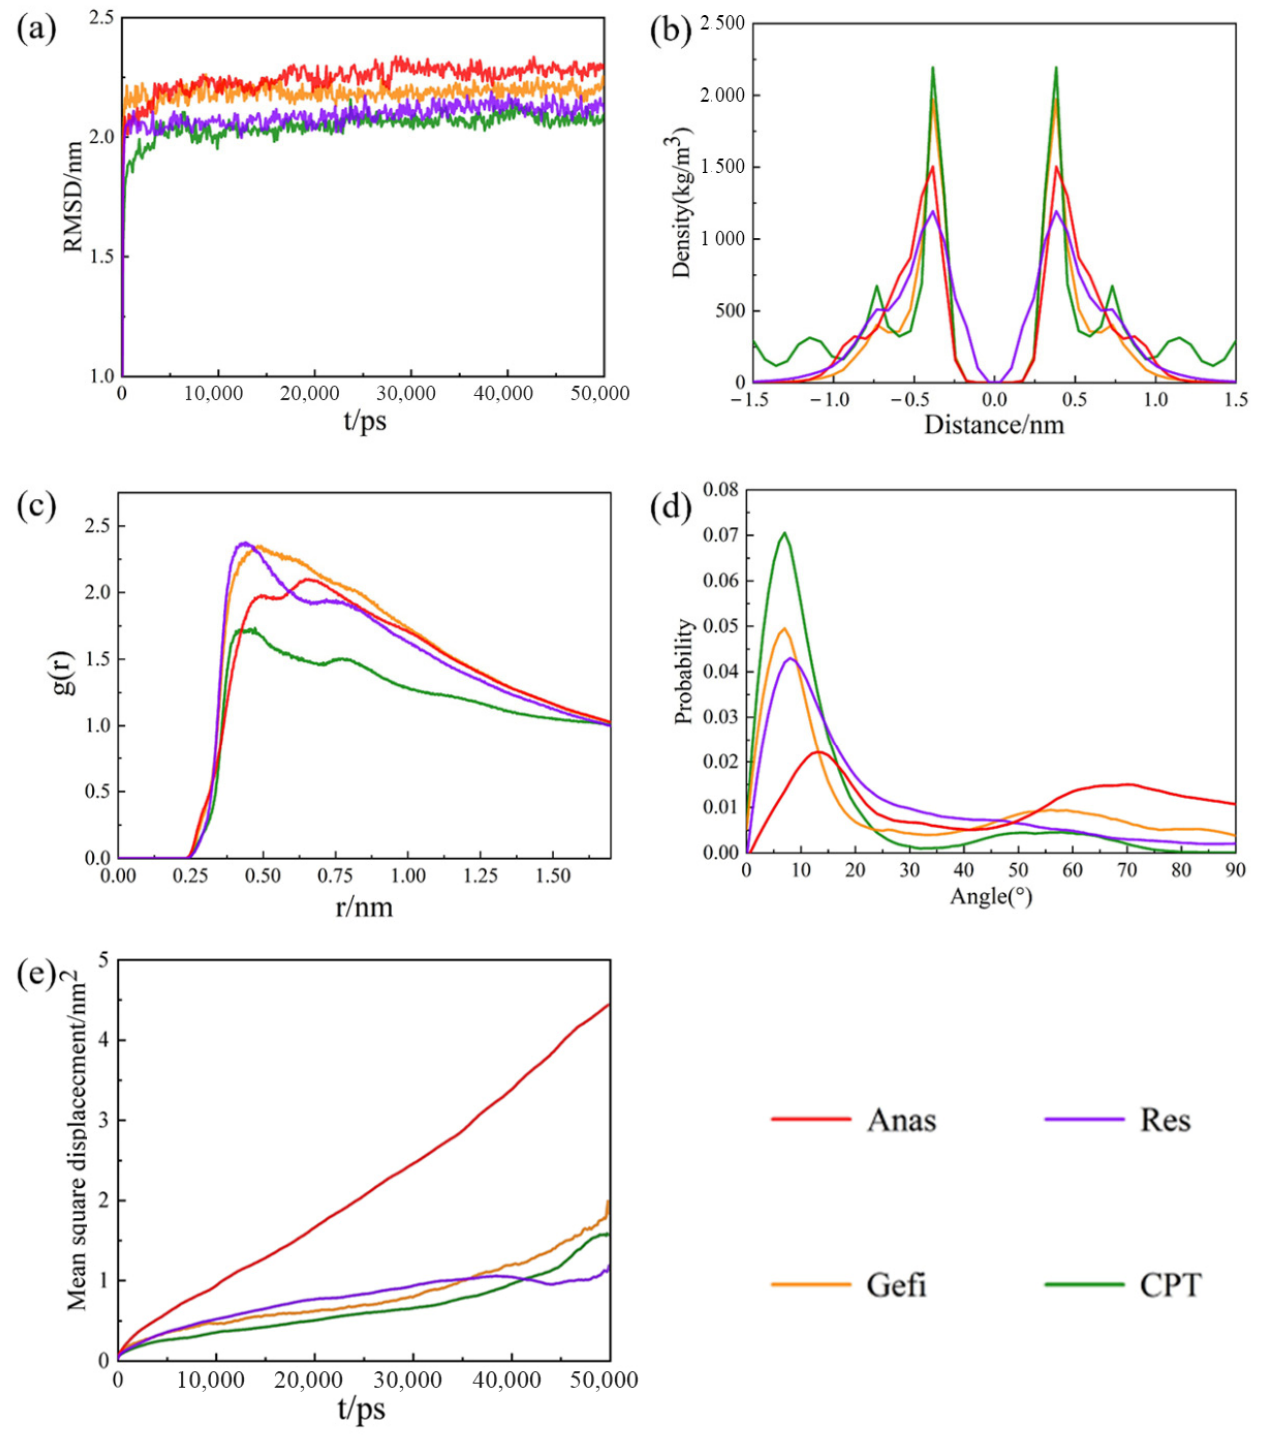
Figure 3. ( a ) The RMSD plots of the system with different drugs adsorbed on graphene as function of time. ( b ) Mass density profiles of different drugs. The center of graphene is set as distance = 0. ( c ) Radial distribution functions (RDF) of the different drug molecules with graphene. ( d ) The probability of the angle between the aromatic rings of the drug molecules and the graphene plane, ( e ) The MSD plots of the different drug molecules with graphene.